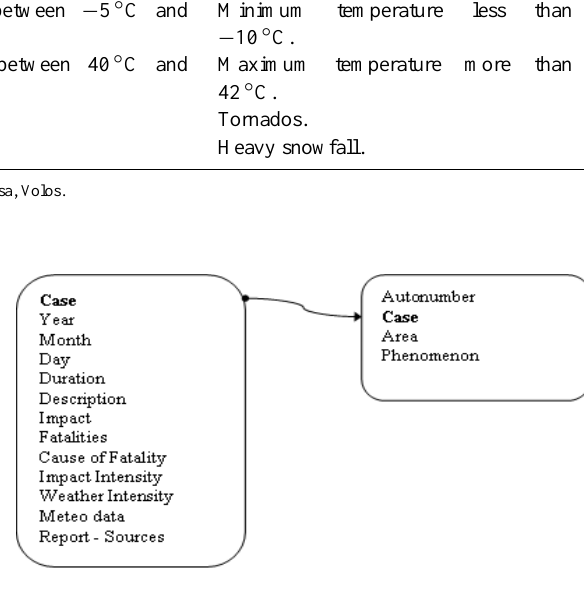
Fig. 1. Design of the relational Access